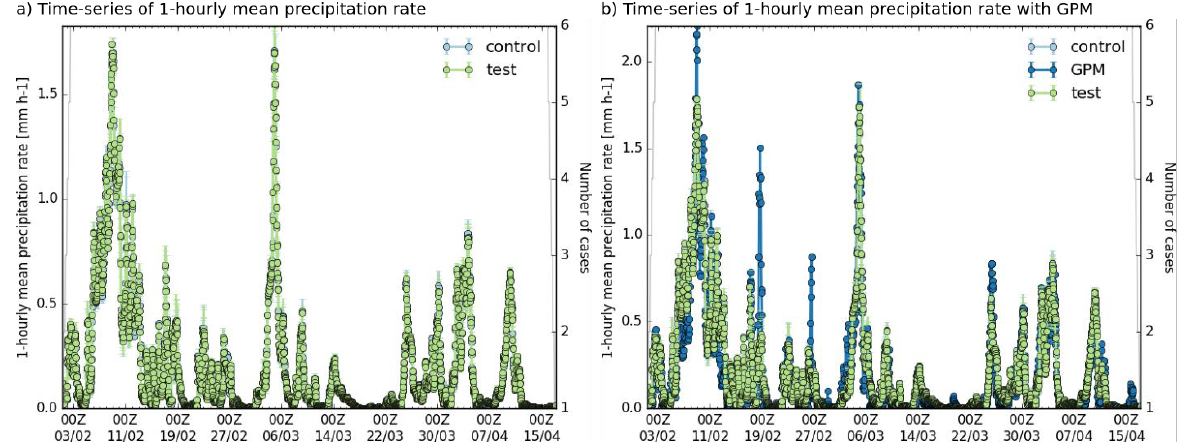
Figure 5. The temporal variations of the hourly mean precipitation rate between the control and test ( a ), and control, test and GPM ( b ).